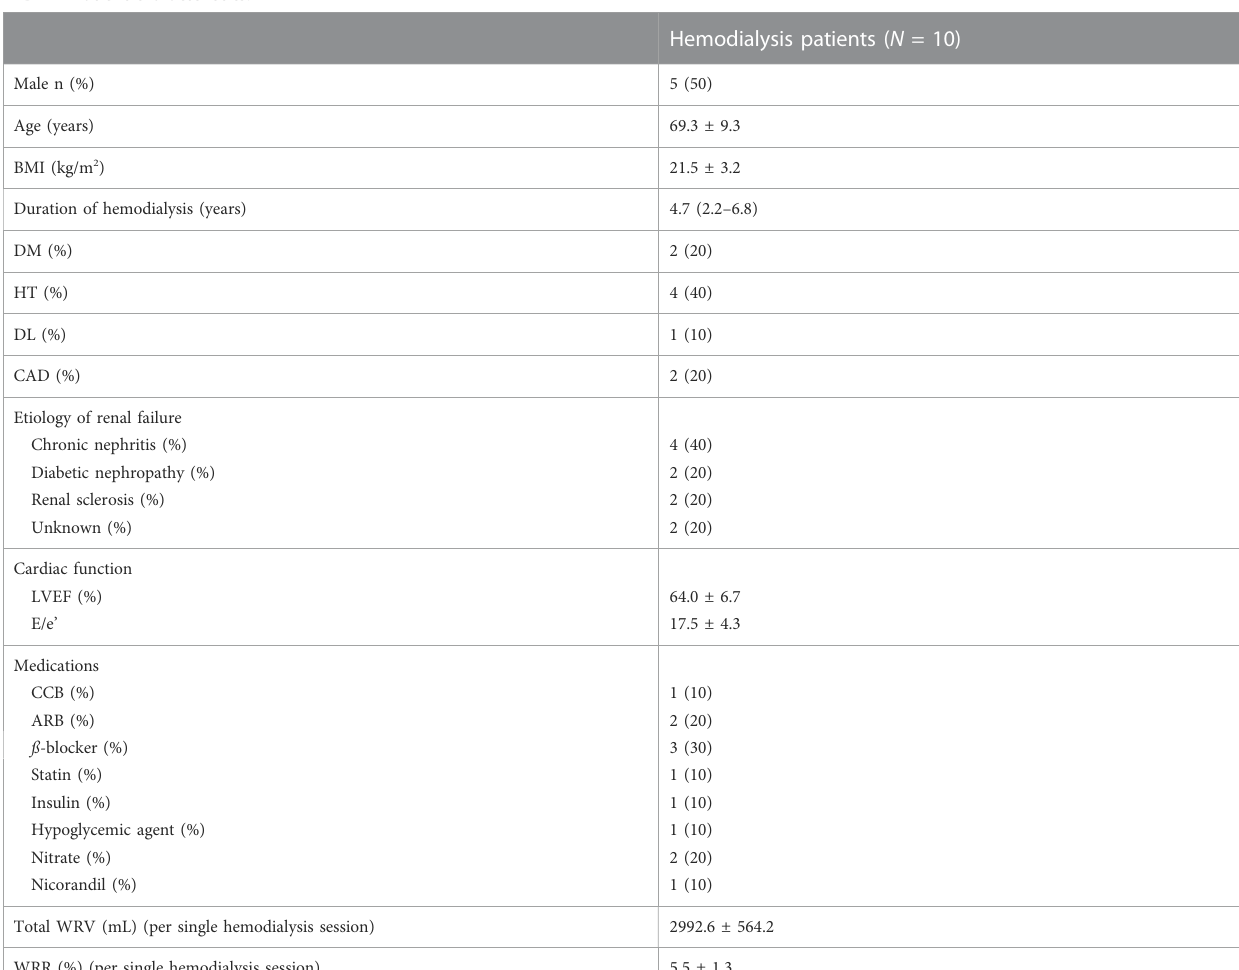
TABLE 1 Patient